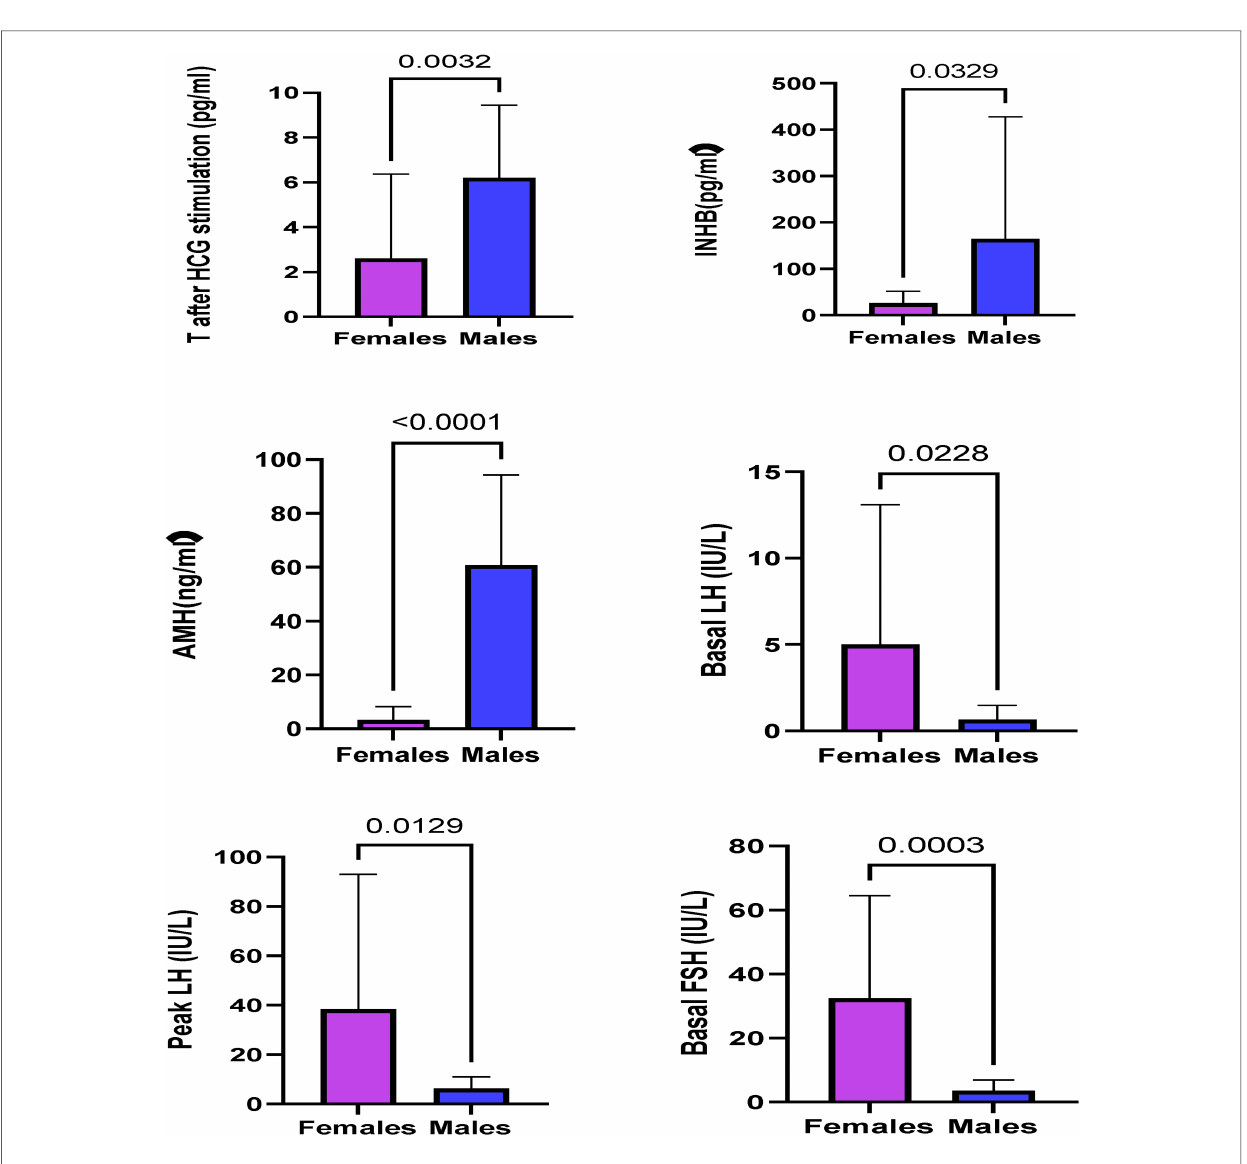
FIGURE 3 Hormones showing signi fi cant differences in the sex of 45,X/46,XY